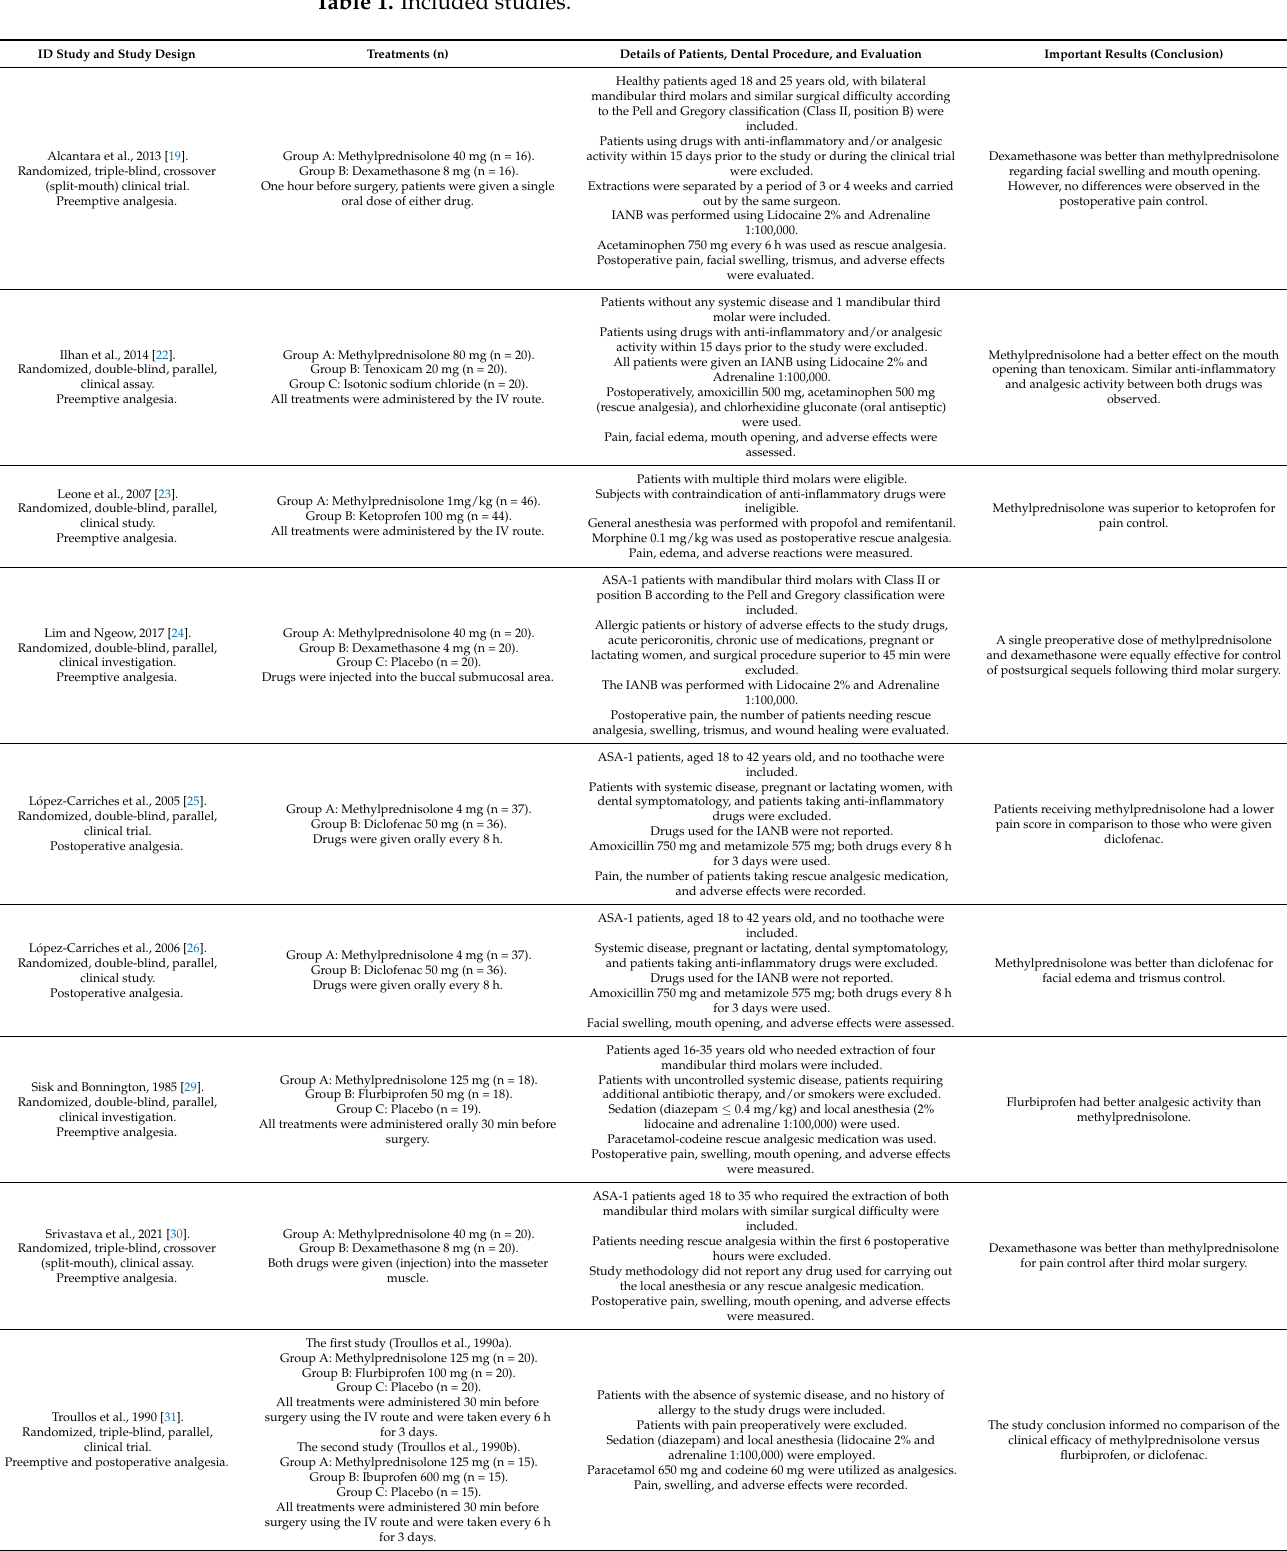
Table 1. Included